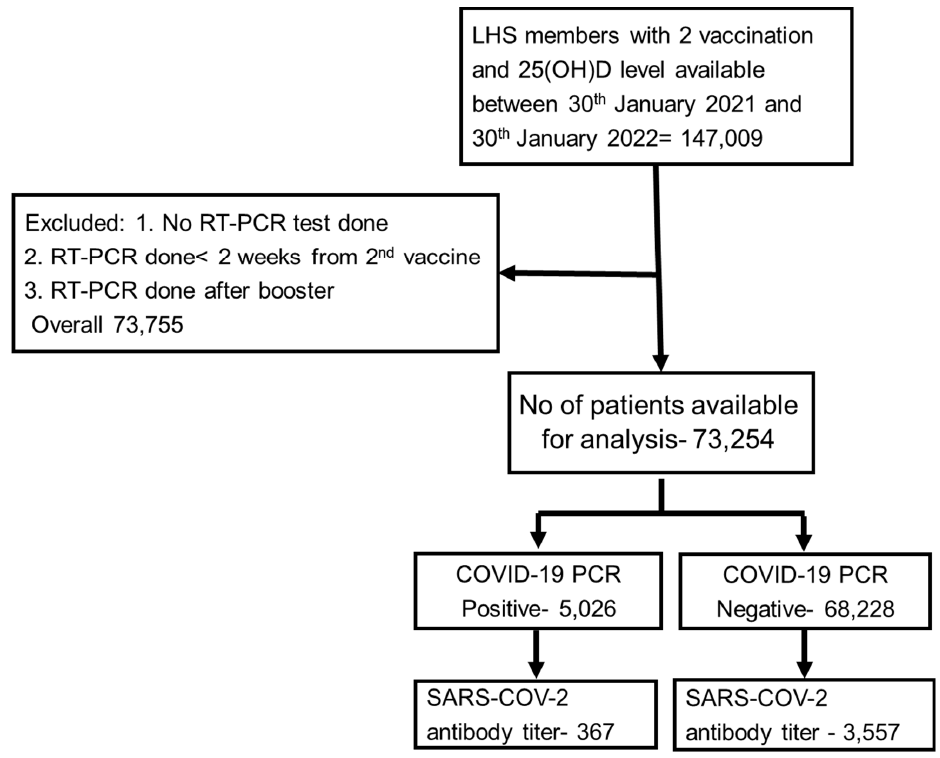
Figure 1. scheme of the study flowchart. Figure 1. Scheme of the study